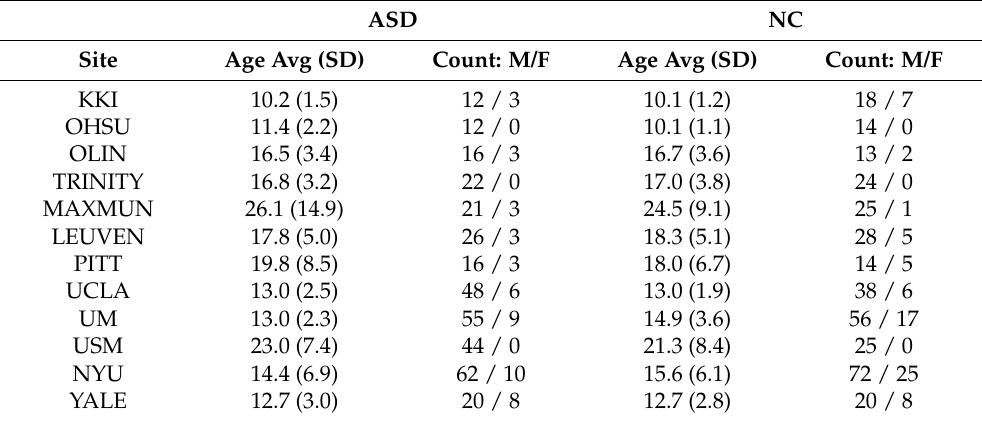
Table 1. Demographic information of the subjects from 12 imaging sites. Average (SD) (SD, standard deviation); M/F: